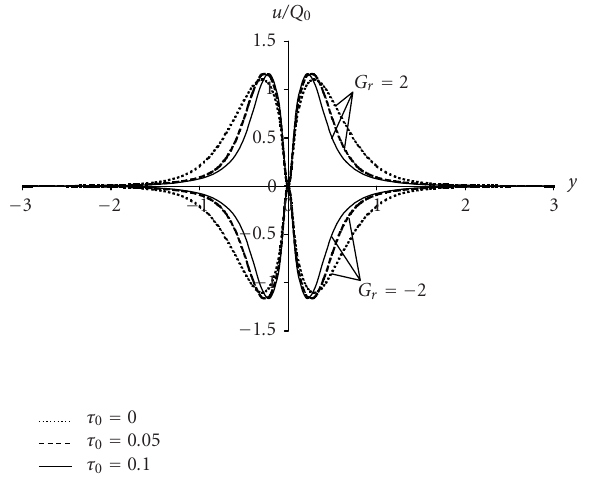
Figure 7.4. The velocity distribution for di ff erent values of τ 0 for the whole-space problem.